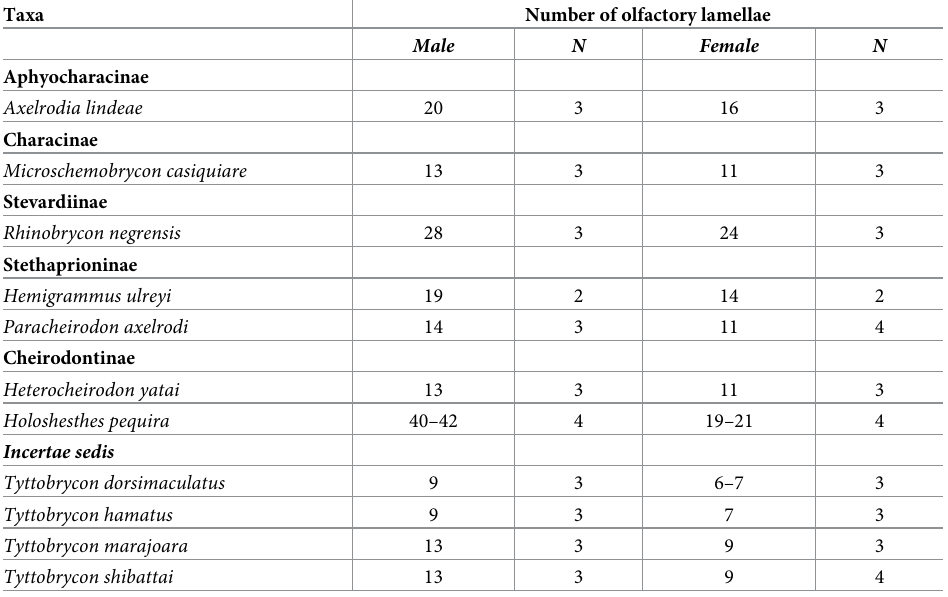
Table 2. List of characids with secondary sexual dimorphism in olfactory organ lamellae and posterior opening of nostrils. N = number of specimens.